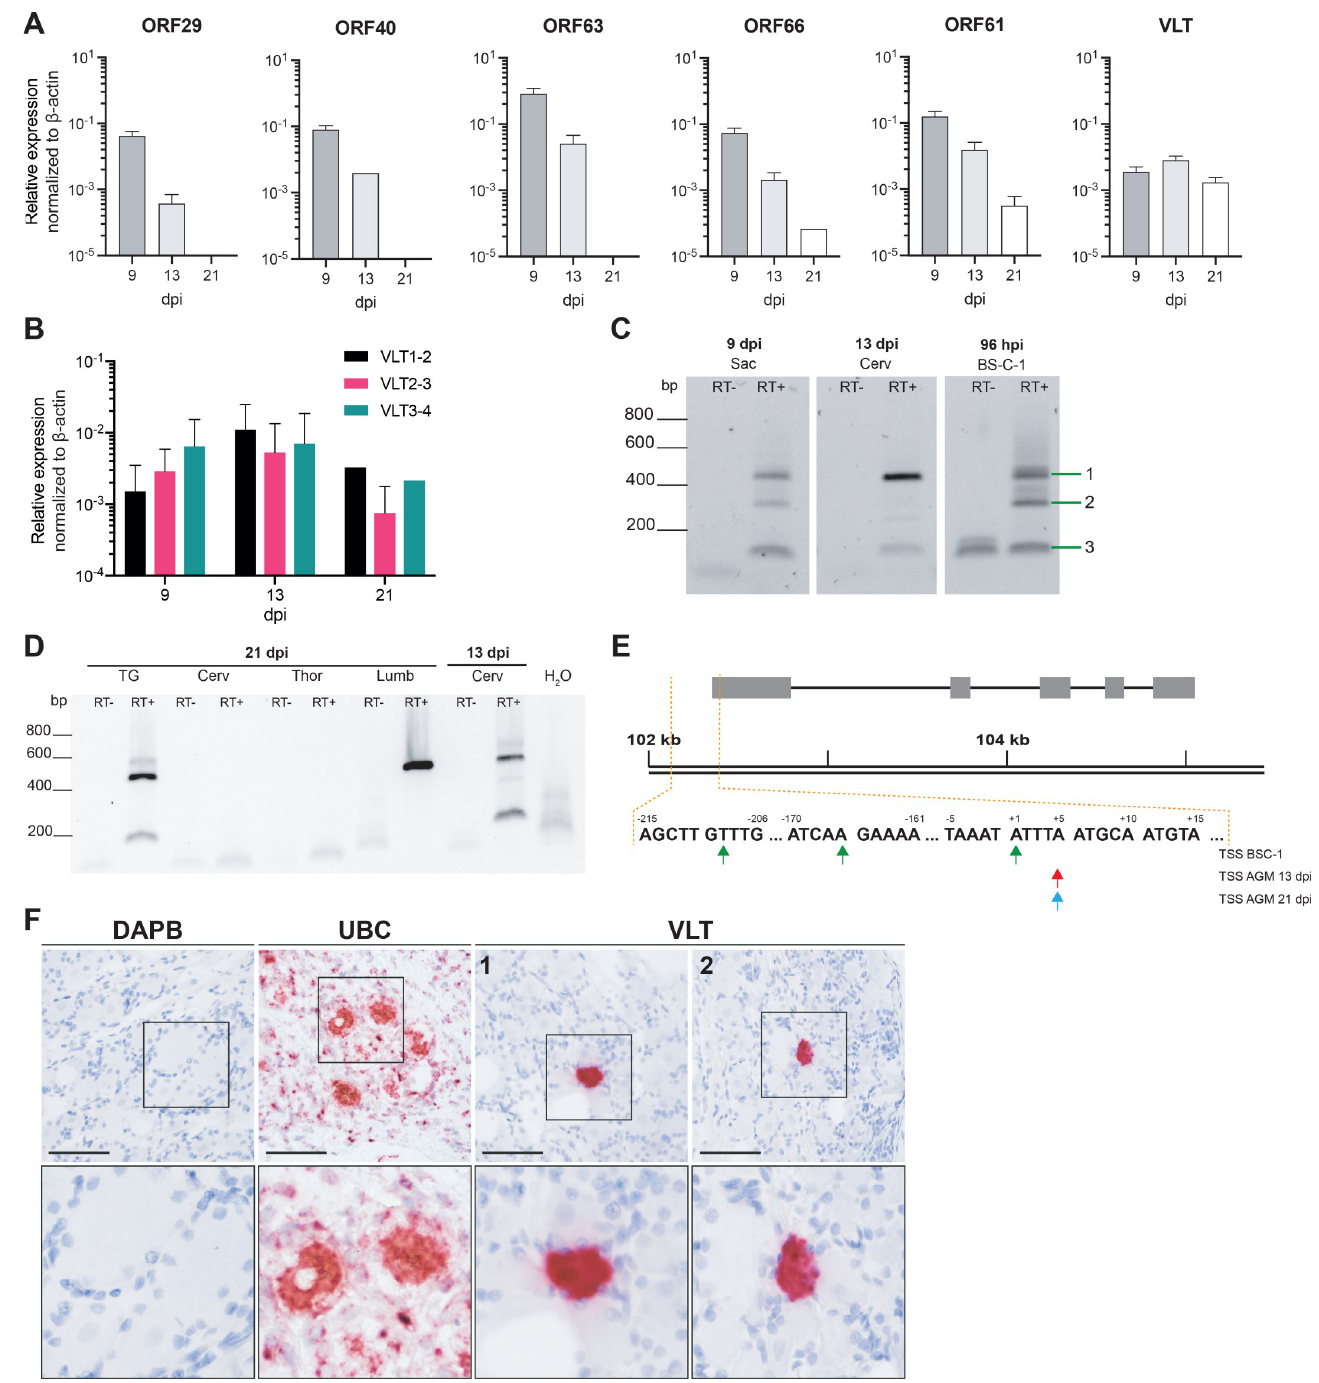
Fig 8. Characterization of VLT expression in ganglia during establishment of latency. (A-B) Detection of lytic SVV RNAs and VLT by qPCR on cDNA obtained from pooled DRG (n = 5 anatomical levels) of SVV-infected AGMs at 9 (n = 2 animals), 13 (n = 2 animals) and 21 (n = 1 animal) days post-infection. Data represent mean ± SEM. (B) Comparison of three VLT exon-spanning primer-probe pairs. (C) RT-PCR showing VLT expression during lytic infection in cell culture (BS-C-1) at 96 hpi, acute sacral (Sac) DRG infection (9 dpi) and transition to latency in cervical ganglia (13 dpi) using primers located in SVV VLT exon 1 and exon 4. Band numbers correspond to isoforms depicted in Fig 7B. (D) Nested RT-PCR on trigeminal ganglia (TG) and DRG (Cerv = cervical, Thor = thoracic, Lumb = lumbar) obtained from SVV-infected AGM at 13 and 21 dpi, respectively. (E) Transcription start sites of VLT in BS-C-1 cells (top row) or AGM ganglia at 13 dpi (middle row) and 21 dpi (bottom row), as determined by 5’RACE. (F) Detection of VLT RNA (red signal) by in situ hybridization in DRG neurons of a SVV-infected rhesus macaques at 21 dpi. Probes directed to bacterial gene DAPB and abundantly expressed ubiquitin C (UBC) were included as negative